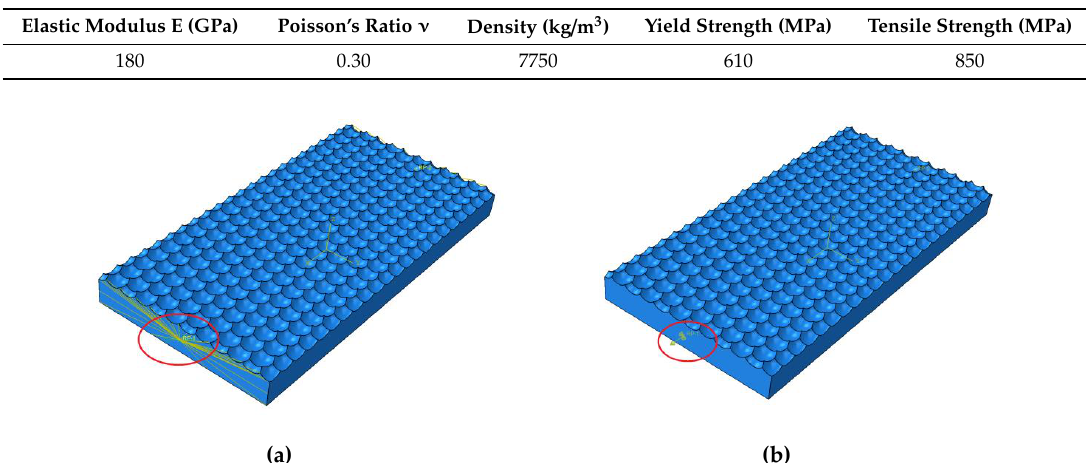
Table 2. Physical characteristics of Cr12MoV hardened steel [32].